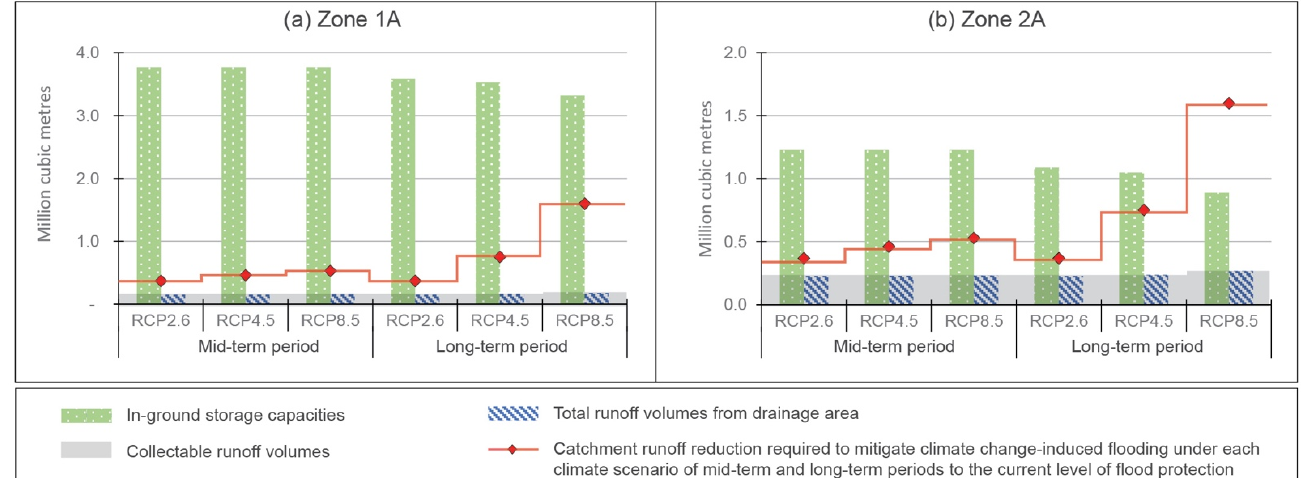
Figure 8. The collectable runoff volumes of Zones 1A and 2A (shaded in grey) correspond to the total amounts of runoff from their drainage areas (blue bar). However, these runoff reductions are not sufficient to meet the flood protection objective under the minor climate change scenario (RCP2.6) in the mid-term period (red line). Despite having a large storage capacity to collect runoff (green bar), their FMCs are limited by the amount of runoff they receive from their drainage